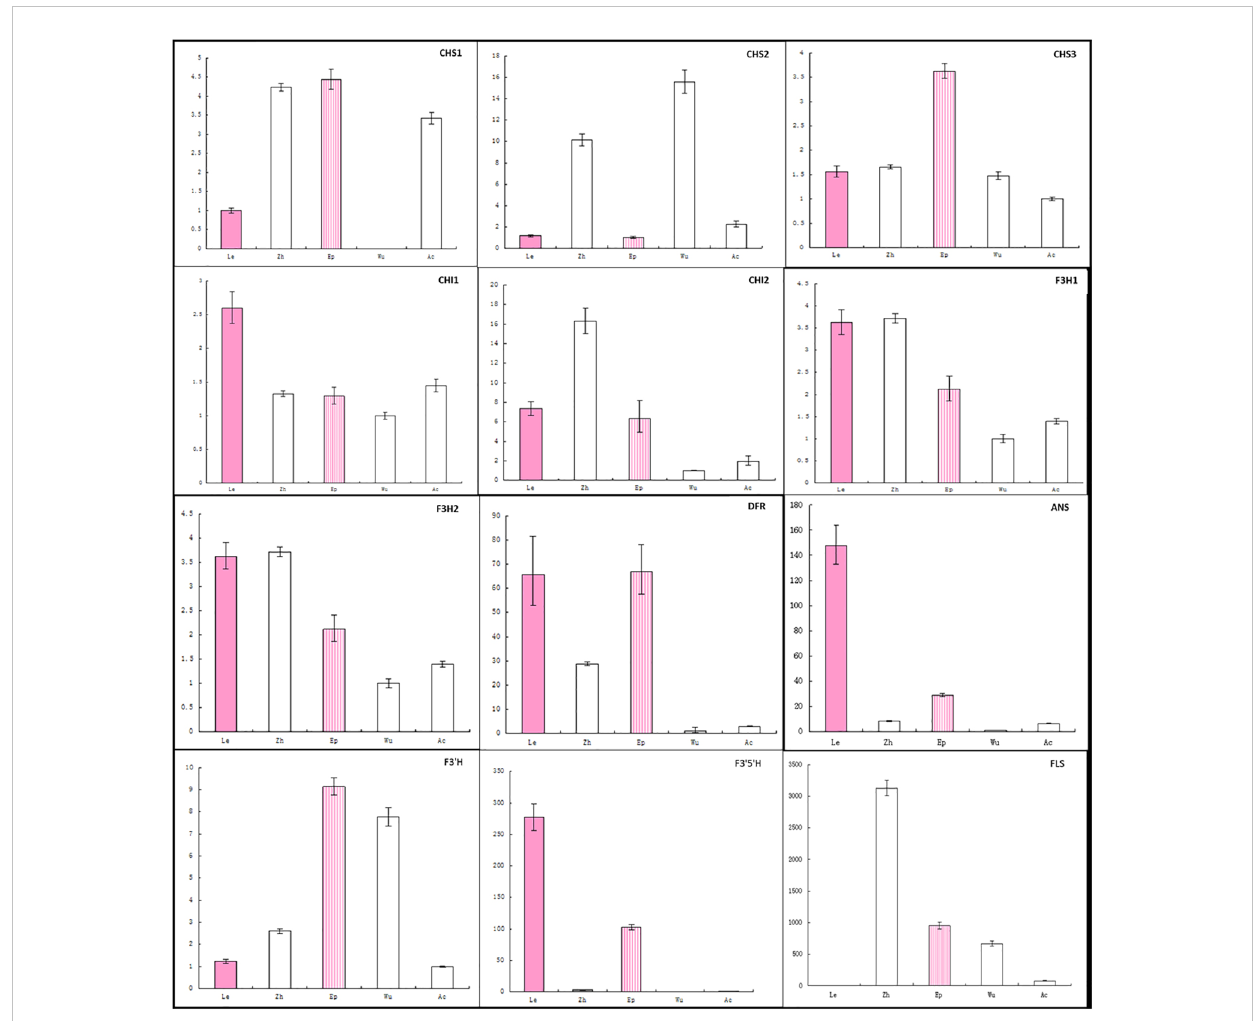
FIGURE 5 Analysis of expression pro fi les of anthocyanin genes in petaloid sepals of fi ve Epimedium species using real-time PCR. The cDNA templates are listed as follows: Le, E. leptorrhizum ; Zh , E. zhushanense ; Ep , E. epstenii ; Wu, E. wushanense and Ac, E. acuminatum . Data presented here are the mean values of three replicates with error bars indicating